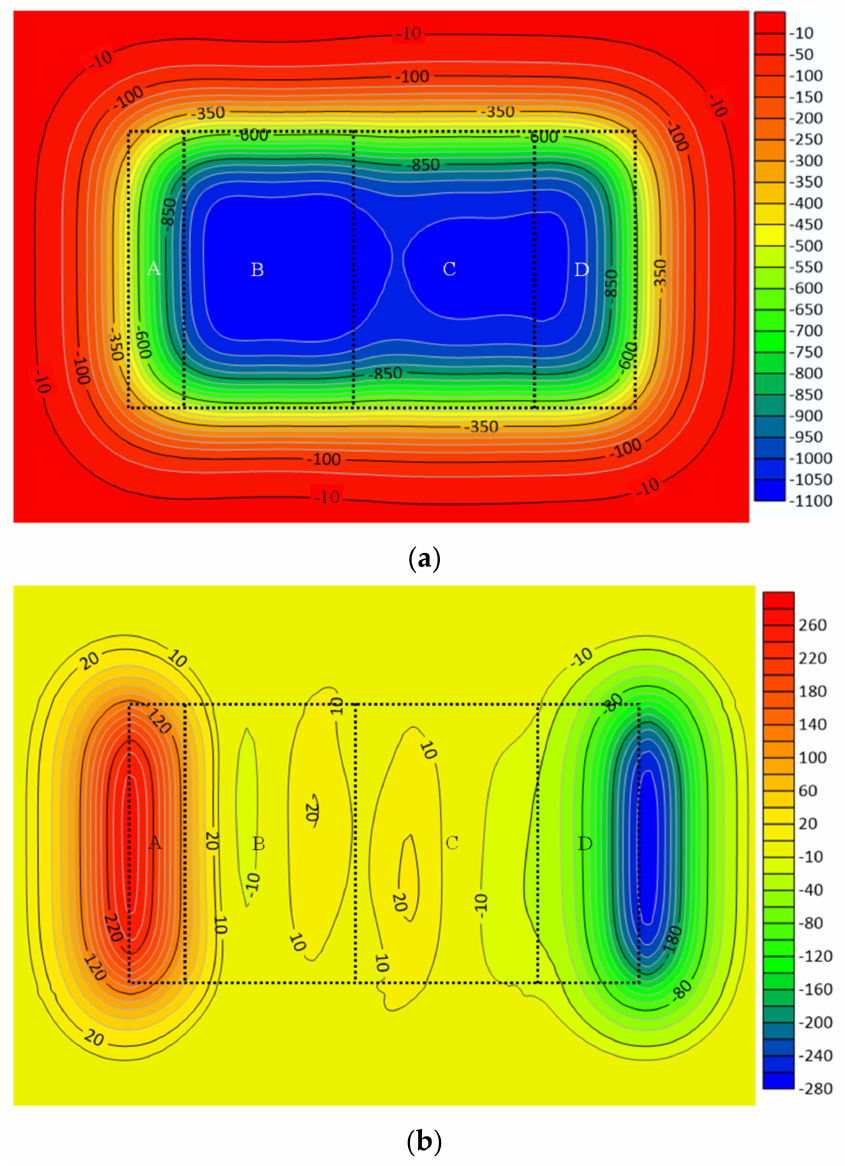
Figure 9. Probability integration calculation result: ( a ) subsidence isoline cloud; and ( b ) horizontal movement isoline